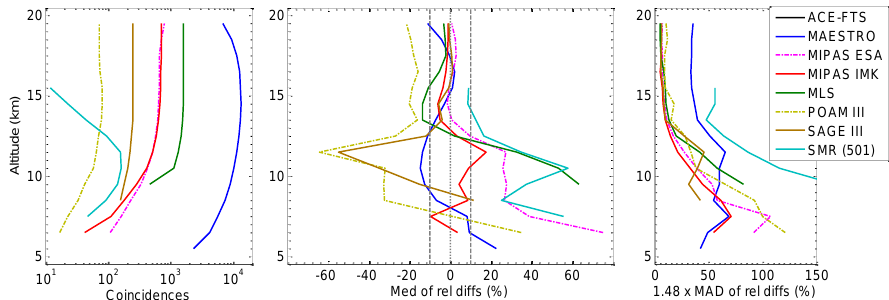
Figure 2. (Left) Number of coincidences globally as a function of altitude between ACE-FTS and various limb sounders that measured water vapour in the ACE time period. The coincidence criteria are < 1h in time and within 250km. (Centre) Median of relative differences in water vapour versus ACE-FTS (the minuend). The profiles from the instrument with the coarser vertical resolution are smoothed to account for the difference in resolution between ACE-FTS and the correlative instrument. ACE-FTS has a coarser vertical resolution than most of the chosen instruments. (Right) Variability of the relative differences. SAGE is the Stratospheric Aerosol and Gas Experiment. MIPAS IMK is the Michelson Interferometer for Passive Atmospheric Sounding water vapour product developed at the Institut für Meteorologie und Klimaforschung (IMK). The MIPAS water vapour product from the European Space Agency (ESA) is also illustrated. SMR is the sub-mm radiometer on Odin, and the Aura MLS (Microwave Limb Sounder) is used.